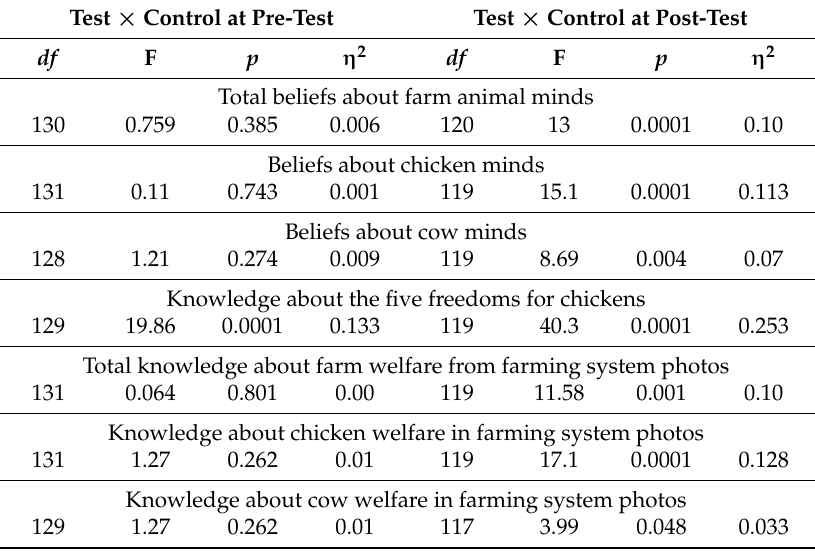
Table 4. Results for simple effects following significant